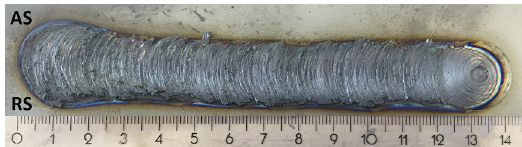
Figure 2. Typical appearance of Titanium Grade 1 deposit with 4000 rpm